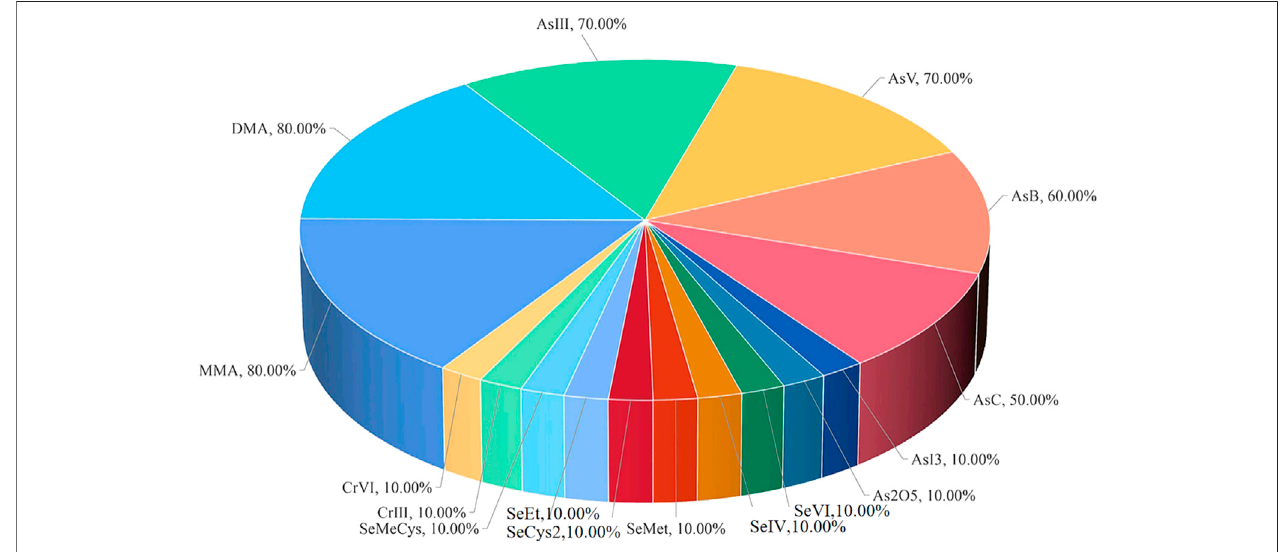
FIGURE 6 | Determination of element content and proportion pie chattachment.art in medical materials and Chinese patient medicines by ICP-MS.